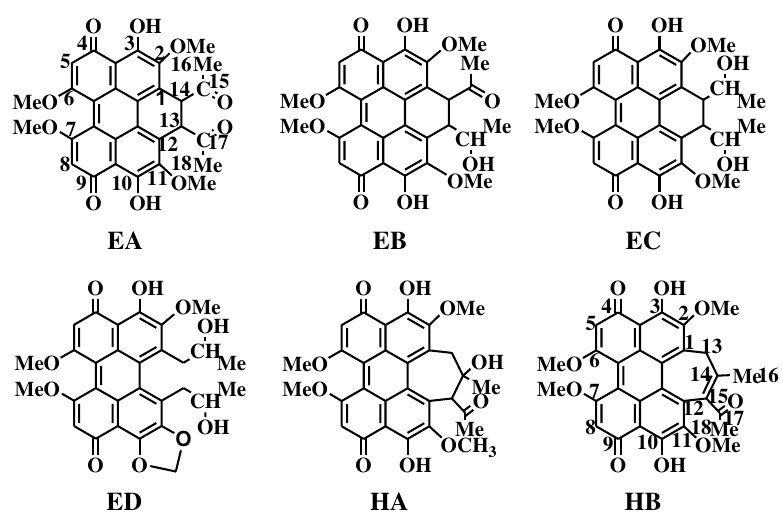
Fig. 1. The structures of EA, EB, EC, ED, HA and